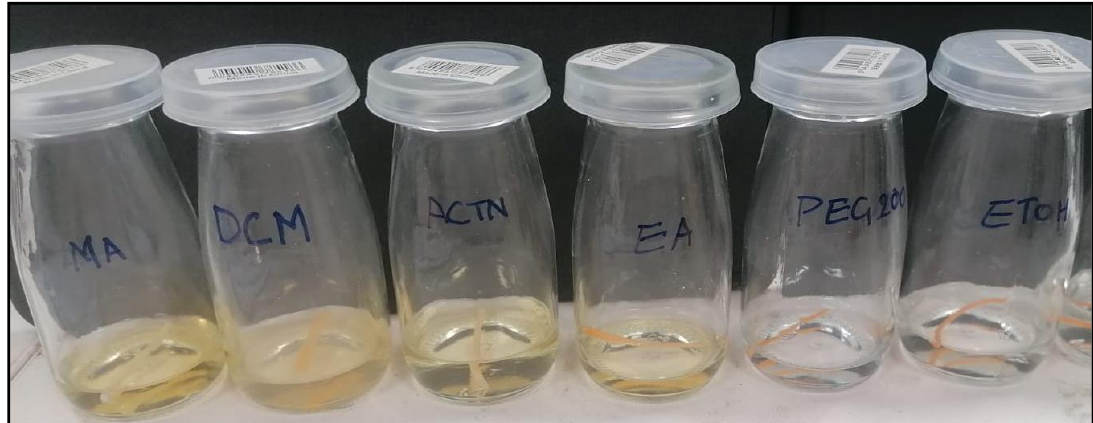
Figure 2. Swelling index study of PLA in the selected organic solvents.